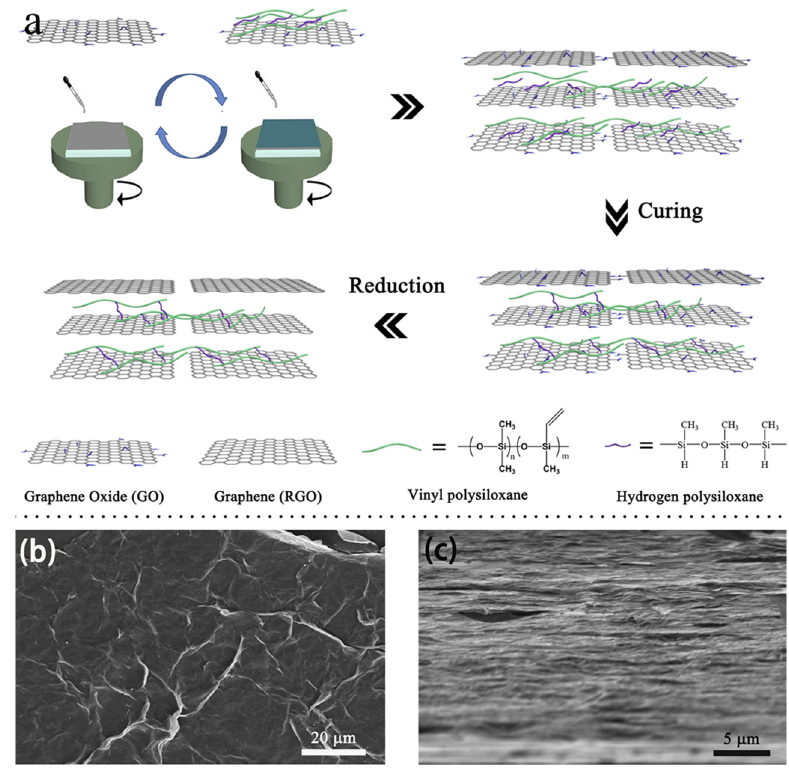
Figure 4. ( a ) Schematic illustration of the proposed fabrication procedure of SR/RGO multilayered films via spin-assisted LBL assembly. ( b ) SEM image of GO on SR. ( c ) Cross-section SEM image of (SR/RGO) 40 film. Reprinted with permission from ref. [50] Copyright 2018, Elsevier.